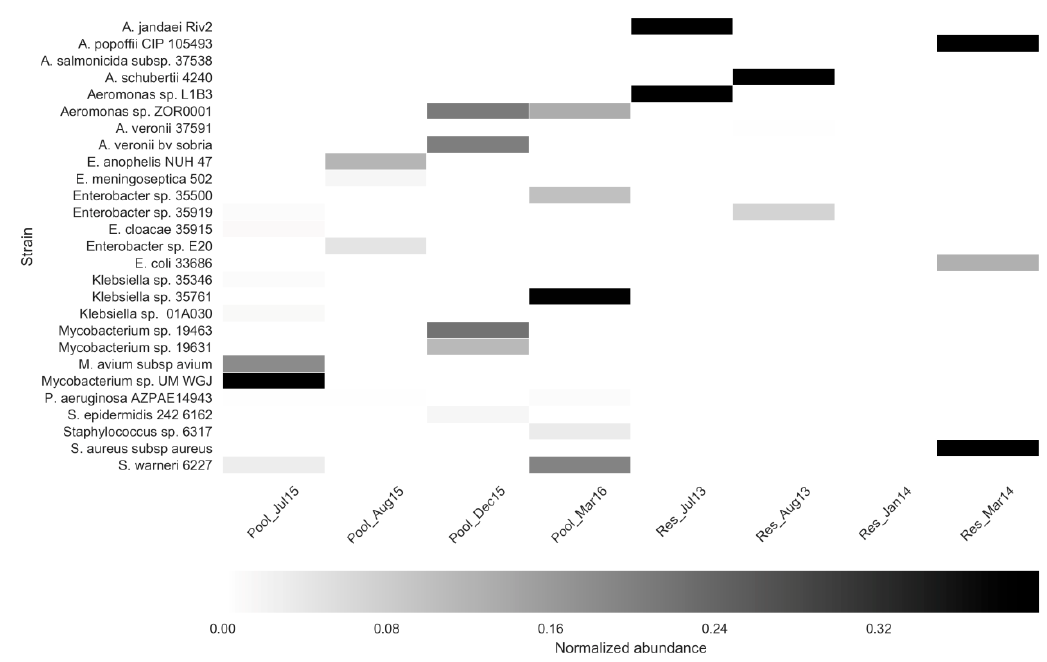
Figure 4. Heat map showing the relative abundance of predominant bacterial pathogens in FP-03 (Pool) and the Res (Res), based on shotgun metagenomic data analyzed using the highly curated COSMOSID pipeline.